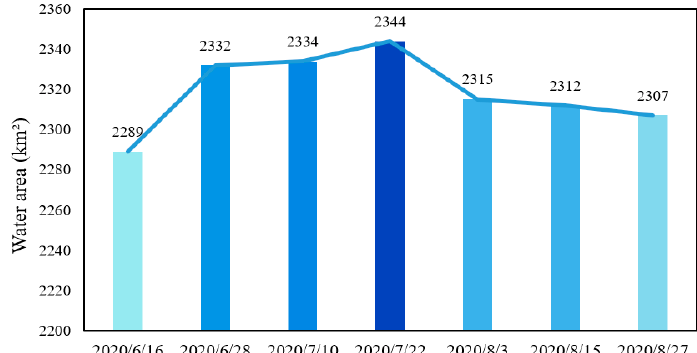
Figure 13. The water area changes of Taihu Lake.